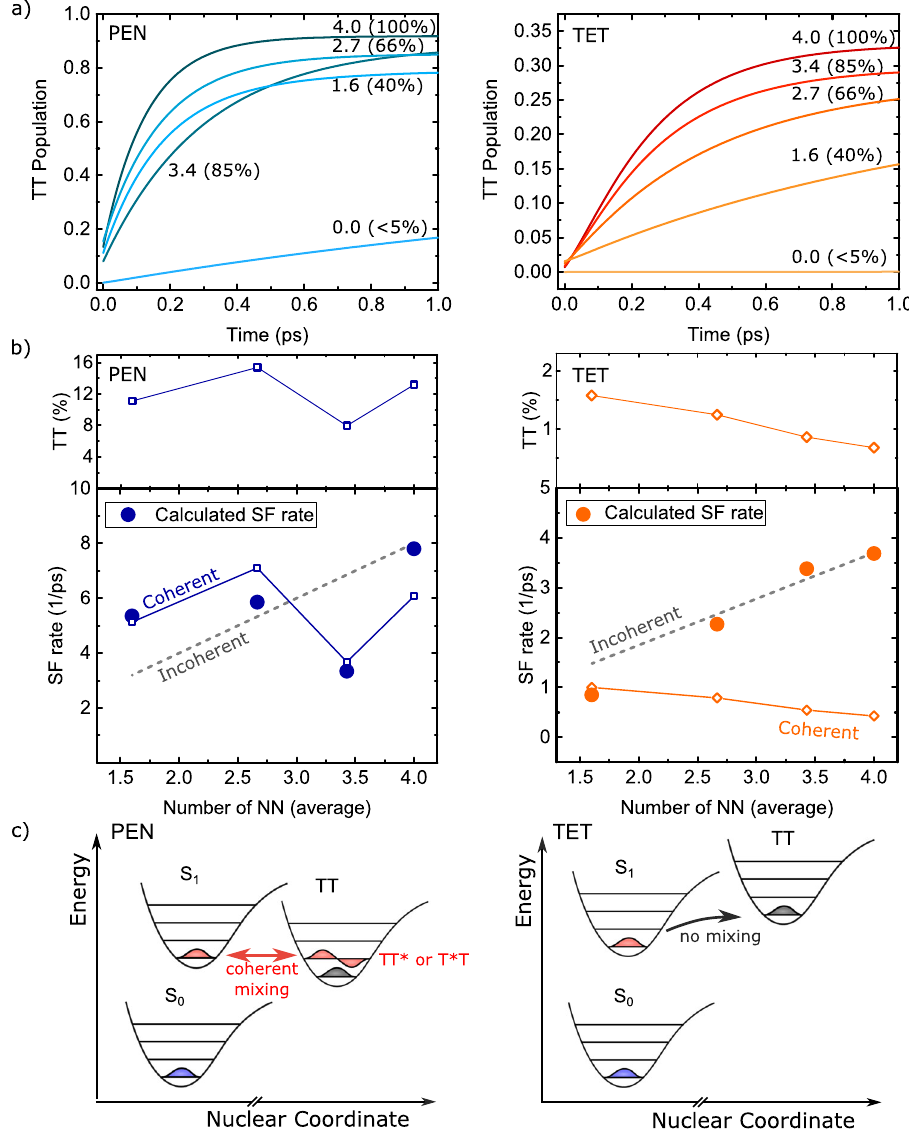
Fig. 3 Triplet-pair-state population and SF mechanisms. a Calculated dynamics of the triplet-pair- (TT) state population for PEN and TET. The numbers indicate the average number of nearest neighbours (NN) and the corresponding PEN or TET fraction in the blend. b Top panel: TT admixture into the photoexcited singlet state. Bottom panel: Reproduction of the calculated SF rates (unscaled) from Figs. 2c, d ( fi lled circles), shown alongside rescaled values of the TT admixture (open symbols, solid lines) and the number of nearest neighbours (dashed lines). Correlations between the SF rates and these values are indicative of the relative coherent and incoherent contributions to the dynamics, respectively. All values for zero nearest neighbours vanish for trivial reasons, see main text, and are not shown here. c Schematic of the two pathways of SF in PEN and TET. Due to the endothermicity of SF in TET, the triplet-pair states cannot coherently mix into the photoexcited singlet state, in contrast to PEN where such mixing is mediated by a vibrational quantum (denoted by the